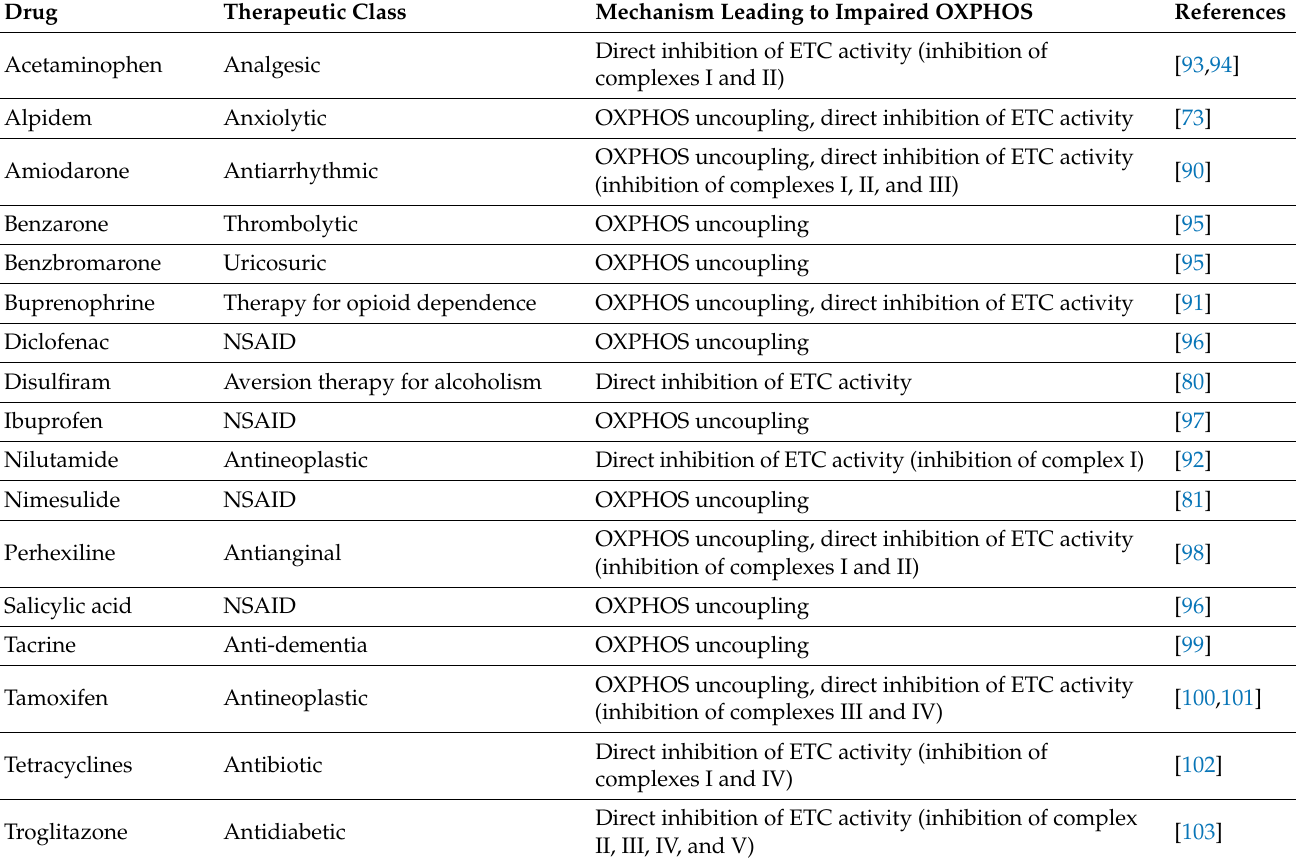
Table 2. DILI drugs reported to induce OXPHOS impairment. (DILI—drug-induced liver injury; OXPHOS—oxidative phosphorylation; ETC—electron transport chain; NSAID—nonsteroidal anti- inflammatory